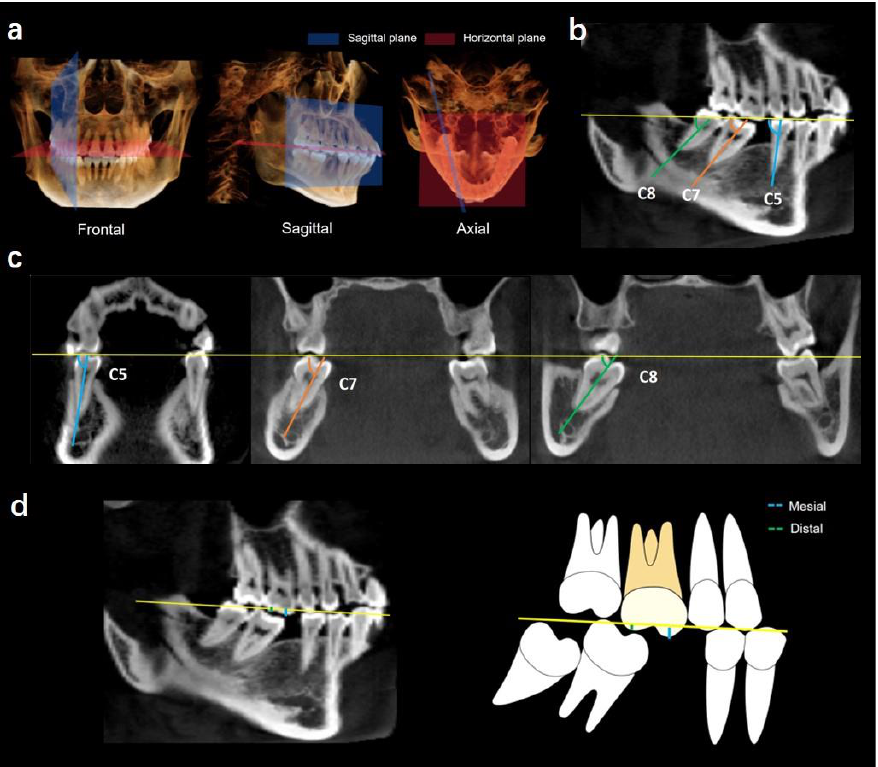
Figure 1. ( a ) Three-dimensional view of the coordinate plane. ( b ) Mesiodistal angulation of C5, C7, C8. The angles were measured in relation to the posterior tooth reference line. ( c ) Buccolingual angulation of C5, C7, C8. The angles were measured in relation to the posterior tooth reference line. ( d ) Overeruption of the maxillary first molar. The extent of extrusion was measured from the coordinate line (in yellow) to the tips of the mesial and distal cusps. The distances between the reference line and the molar cusps (the mesial cusp in blue and the distal cusp in green) were measured.